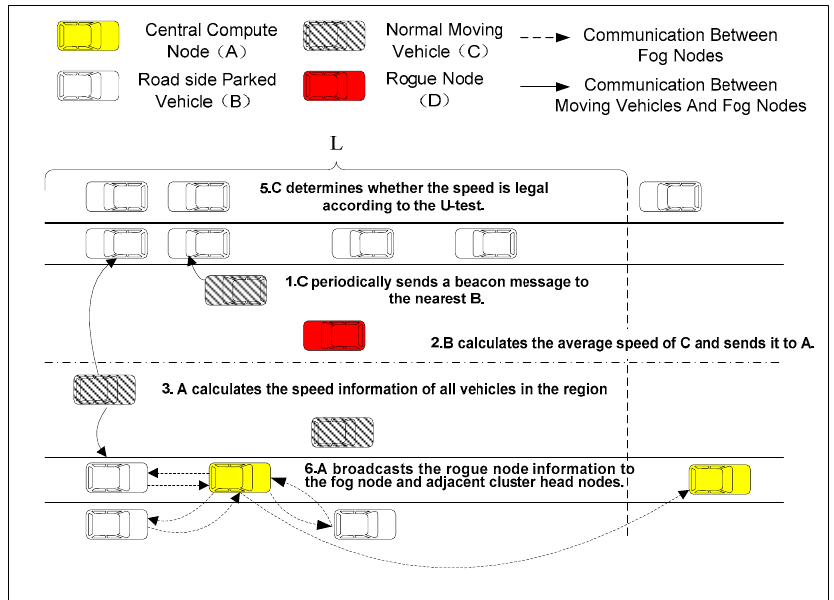
Figure 6. The basic idea of the scheme.